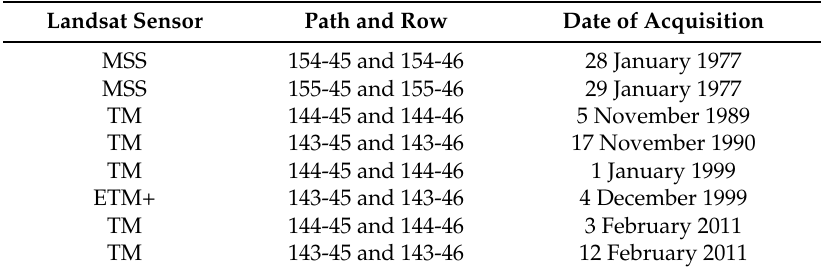
Table 2. Description of Landsat image, its path and row and date of acquisition. Landsat Sensor Path and